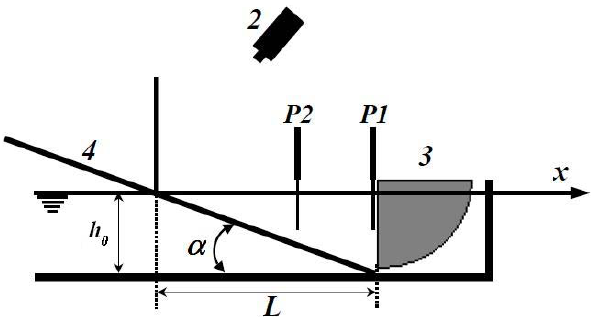
Fig. 2. Schema of experiment: resistive probes (P1, P2), high-speed video camera (2), wave maker (3), inclined bottom